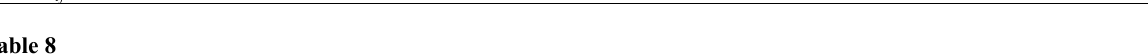
Positive (PIS) and negative (NIS) ideal solutions C01